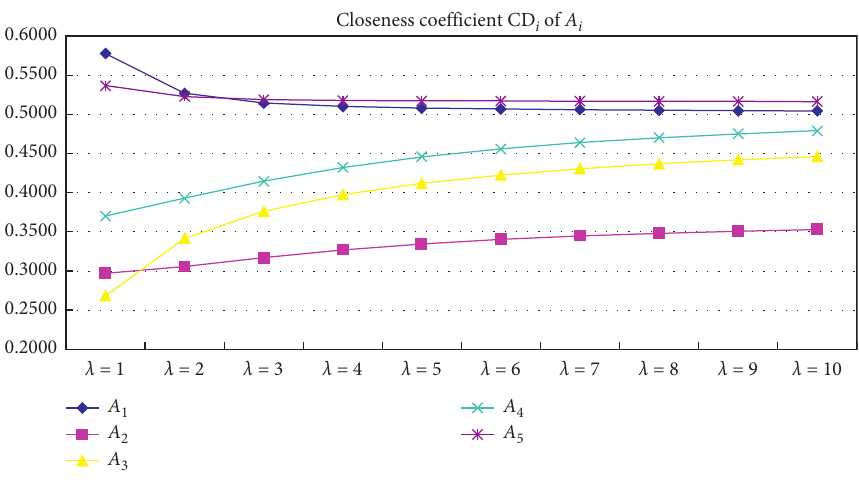
Figure 1: CD i based on MGPL-TOPSIS. Table 14: The compromise index CI i based on MGPL-ETOPSIS.